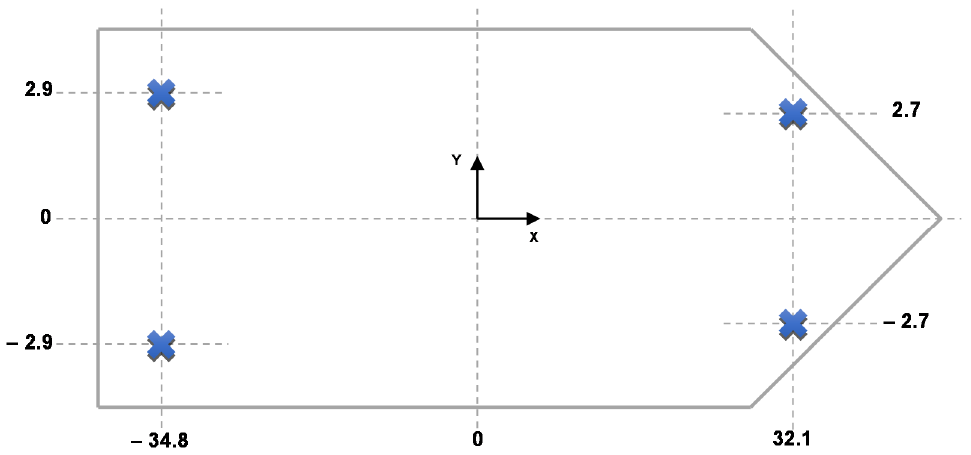
Figure 14. Layout of the windlasses on the ship.